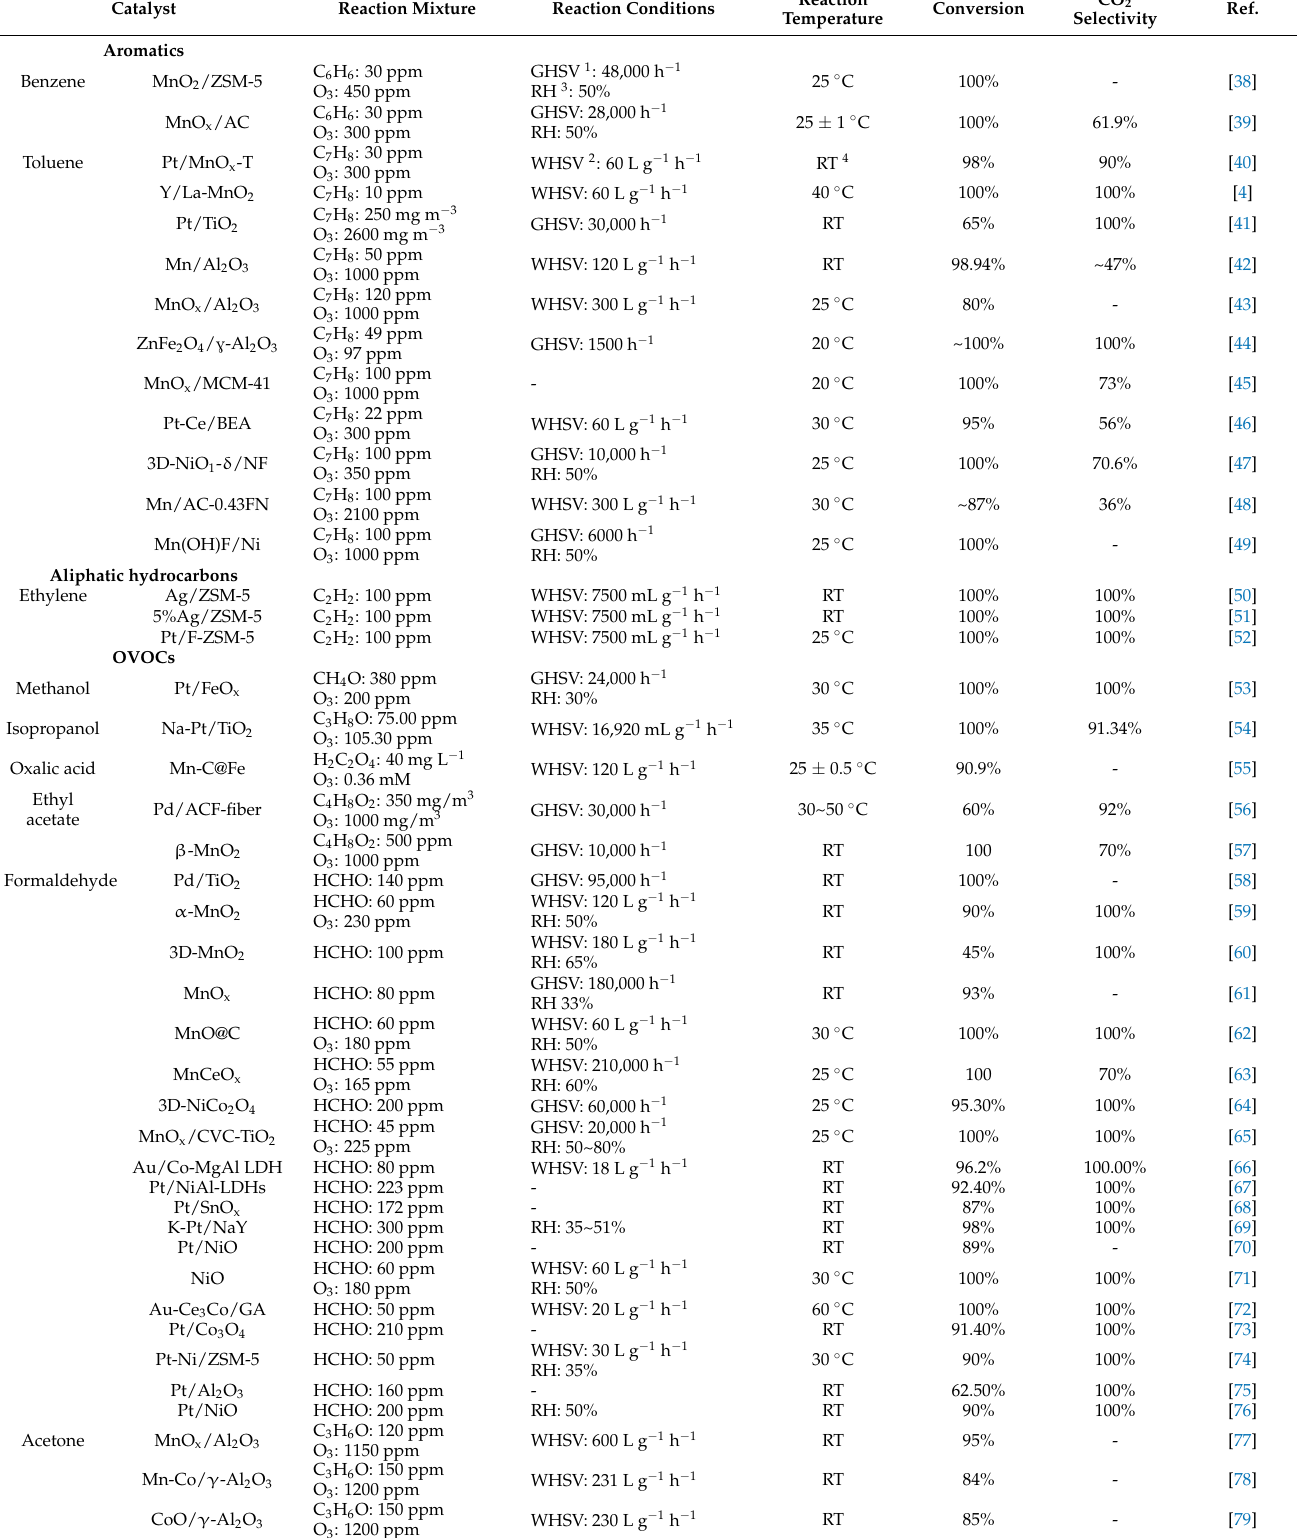
Table 1. Summary of typical catalysts for catalytic elimination of VOCs at ambient